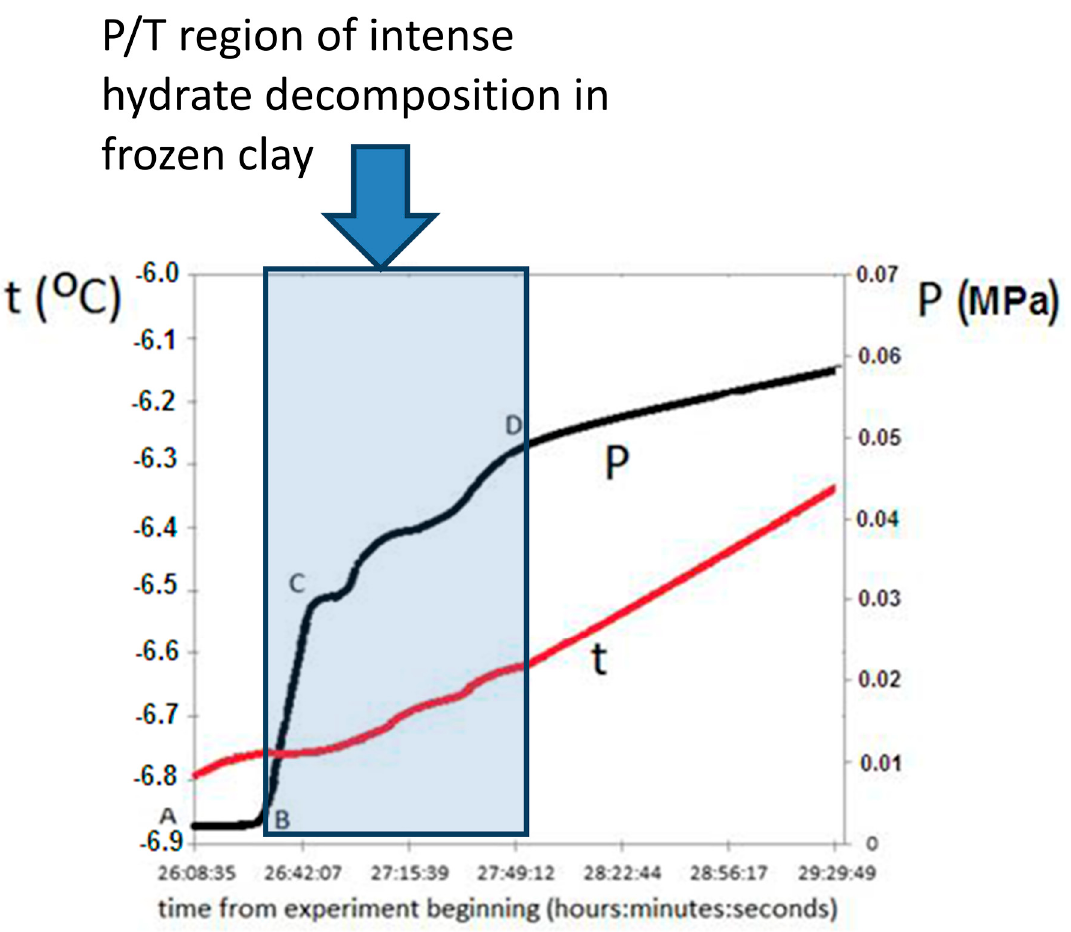
Figure 3. Experimental curves of pressure (P) and temperature (t) changes inside the cell when slow heating of hydrate-containing sample [13].The experiment shows, that frozen mineralized hydrate-containing clays can provide liberation of considerable volumes of gas at negligible temperature changes in permafrost section.